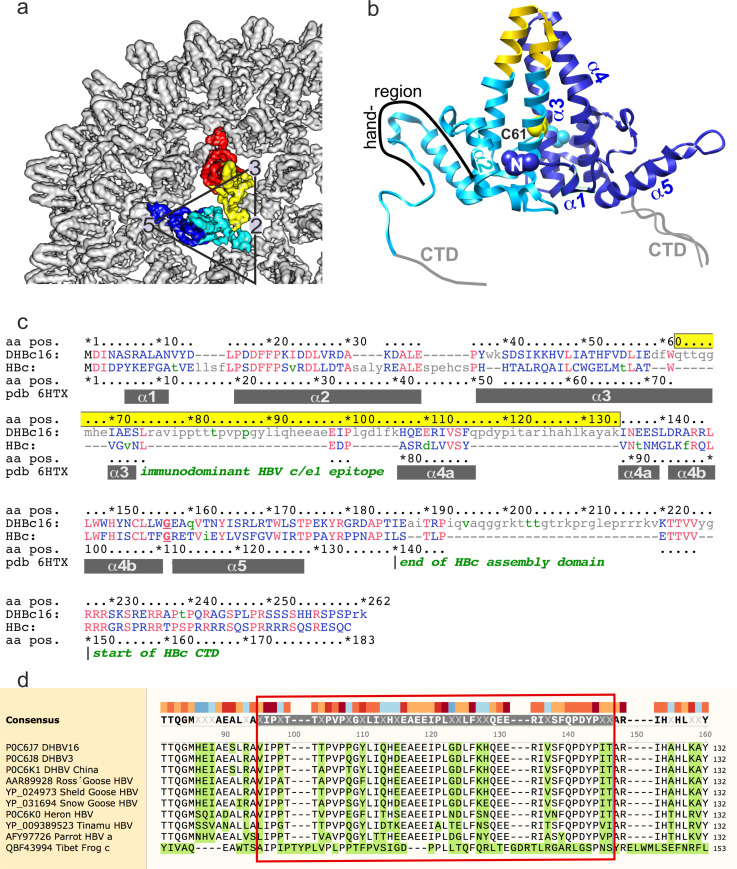
Organization of HBc.(a) Surface representation of a segment of HBc CLPs (Böttcher and Nassal, 2018), with the subunits in one asymmetric unit highlighted in color (blue chain A, cyan chain B, yellow chain C, red chain D). (b) Representation of the AB-dimer of the asymmetric unit. The naming of the helices follows Wynne et al., 1999. Inter-dimer contacts are formed between the hand-regions. Inner dimer contacts in HBc can be stabilized by a disulfide-bridge between Cys61 in HBc. (c) PFAM alignment of HBc and DHBc. The alignment corresponds to Conserved Protein Domain Family pfam00906 Hepatitis_core, except that the primary sequences were adapted (lower case green letters) to match the isolate-specific DHBc and HBc proteins used here (Uniprot IDs: P0C6J7.1 and P03146.1, respectively). Identical residues are shown in red, lower case grey letters indicate non-aligning residues. Grey bars show the positions of HBc helices α1 to α5 as in pdb: 1QGT; HBc domain borders are indicated in dark green. DHBc sequence 62–134 (highlighted in yellow) is predicted to replace HBc sequence 71–89, i.e. the spike tip comprising the C terminal part of α3, the connecting loop (the c/e1 epitope) and the N terminal part of α4. DHBc sequence 78–122 (light-green box) represents the biochemically predicted and here directly confirmed extension domain at the spike tip. (d) Conservation of the extension domain sequence among hepadnaviral large type CPs: The indicated CP sequences with their Uniprot and/or NCBI accession numbers were aligned using Clustal Omega as implemented in SnapGene v. 5. Tibet Frog c refers to one of three published Tibetan Frog HBV sequences. Conservation is indicated by colored blocks, with dark blue indicating the lowest and dark red the highest conservation. Residues differing from the consensus are shown with green background. The avian HBV CP sequences are highly similar to each other, including in the extension domain (red box around DHBV16 CP aa V77-T122). The frog virus sequence only shares some interspersed key motifs; however, the sequence predicted to align with the DHBc extension domain is also exceptionally rich in proline residues (10 in 48 aa total) which also cluster mostly in the 5'- proximal part.